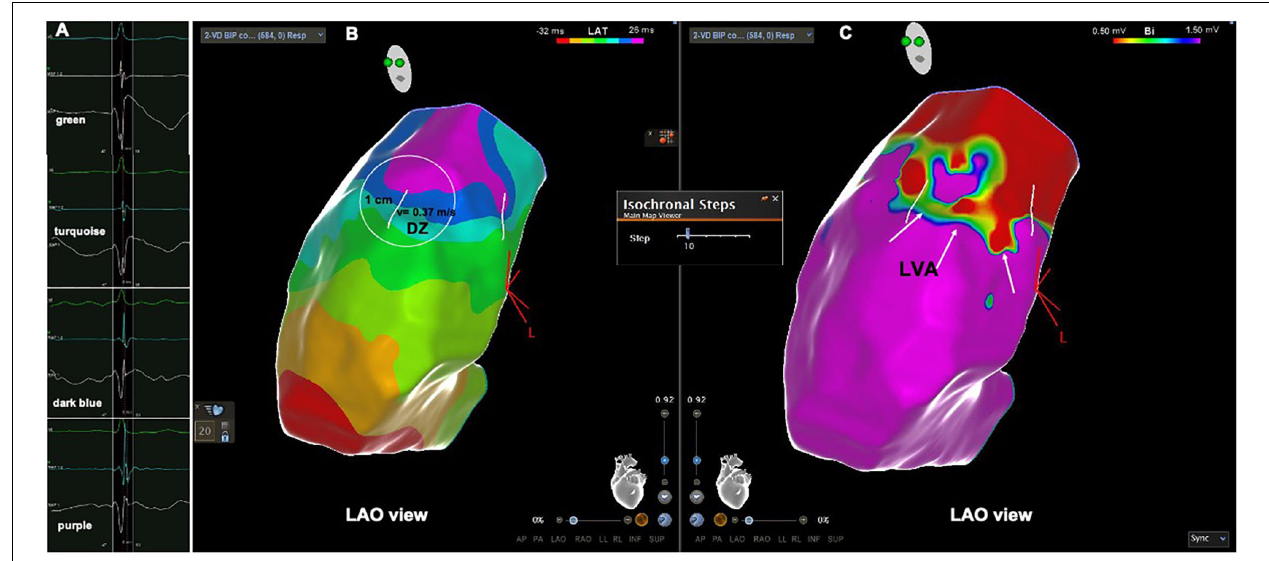
FIGURE 2 | Patient from the PVC group. (A) Intracardiac electrograms corresponding to the respective isochrones presented in the isochronal map. (B) RVOT isochronal map in sinus rhythm with DZ in the RVOT free wall. (C) Voltage map in sinus rhythm with LVA at the same location. DZ, deceleration zone; LVA, low voltage area; RVOT, right ventricular outflow tract.